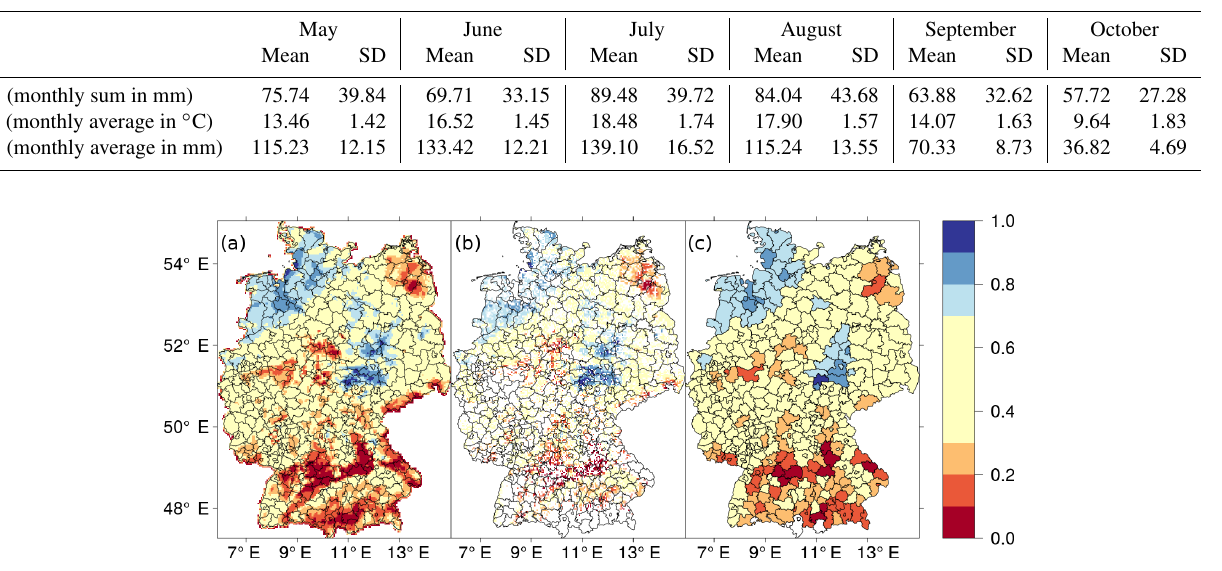
Table 1. Mean and standard deviation of the meteorological variables, averaged over Germany. Data are obtained by the Germany Weather Service.